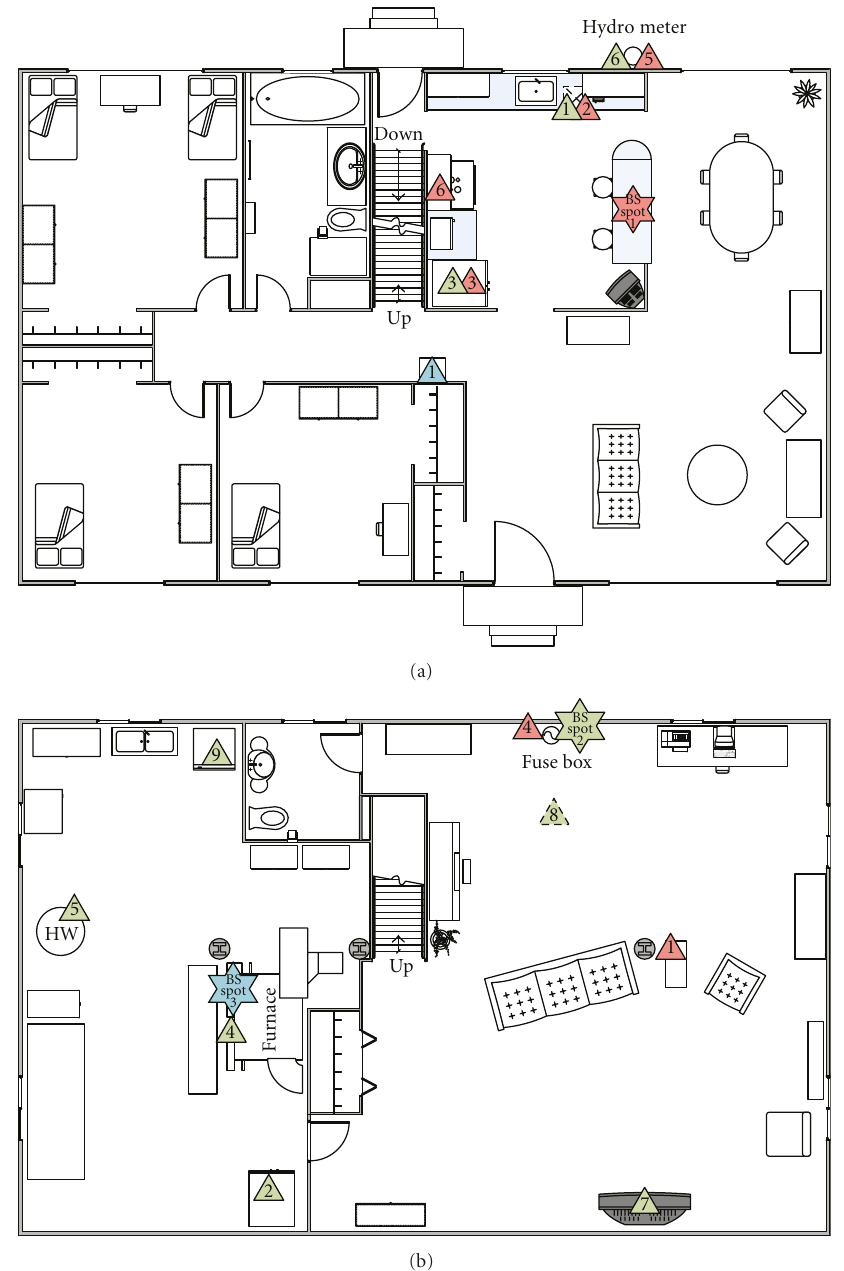
Figure 4: (a) Main Floor Layout. (b) Basement Layout. The triangles represent the transmitter test locations. Red is for trials conducted with the BS in the kitchen. Green is for trials with the BS at the fuse box. Blue is for the trial with the BS at the